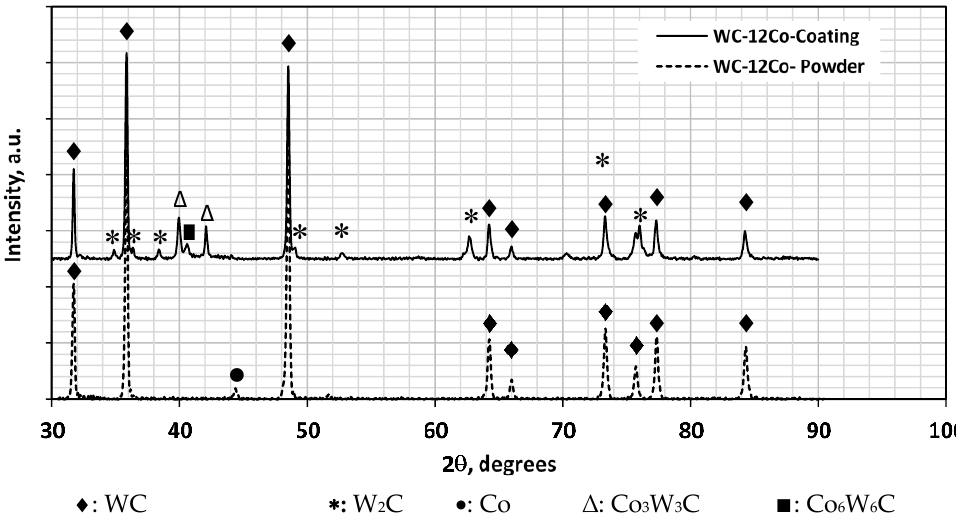
Figure 12. XRD-patterns of WC-12Co in powder and coating conditions.